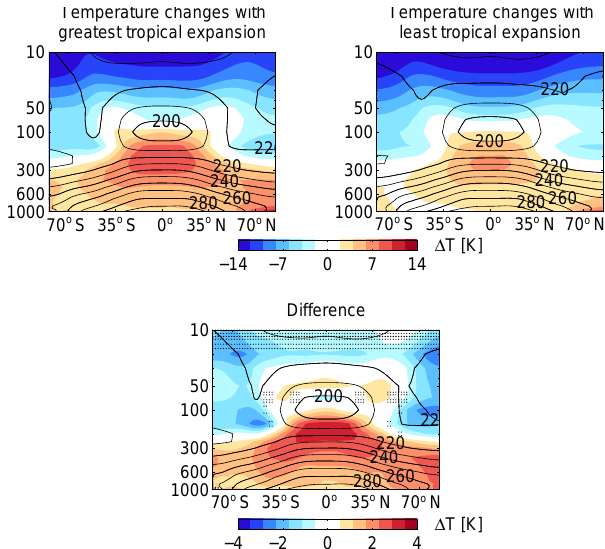
Figure 6. The difference in zonal-mean temperature between the 4 × CO 2 and piControl experiments in the four models with the greatest tropical expansion (upper left) and in the four models with the least tropical expansion (upper right). The 4 × CO 2 experiment minus the piControl experiment temperatures are shown in shading (Kelvin), while the piControl experiment temperatures are shown by the black contours (Kelvin). The difference in the 4 × CO 2 ex- periment minus the piControl experiment temperatures between the models with the greatest and least tropical expansion is shown on the bottom, with shading indicating the difference (Kelvin) and black contours indicating the mean piControl experiment temper- ature (Kelvin) for all models. Stippling indicates changes not sig- nificant at the 95% confidence